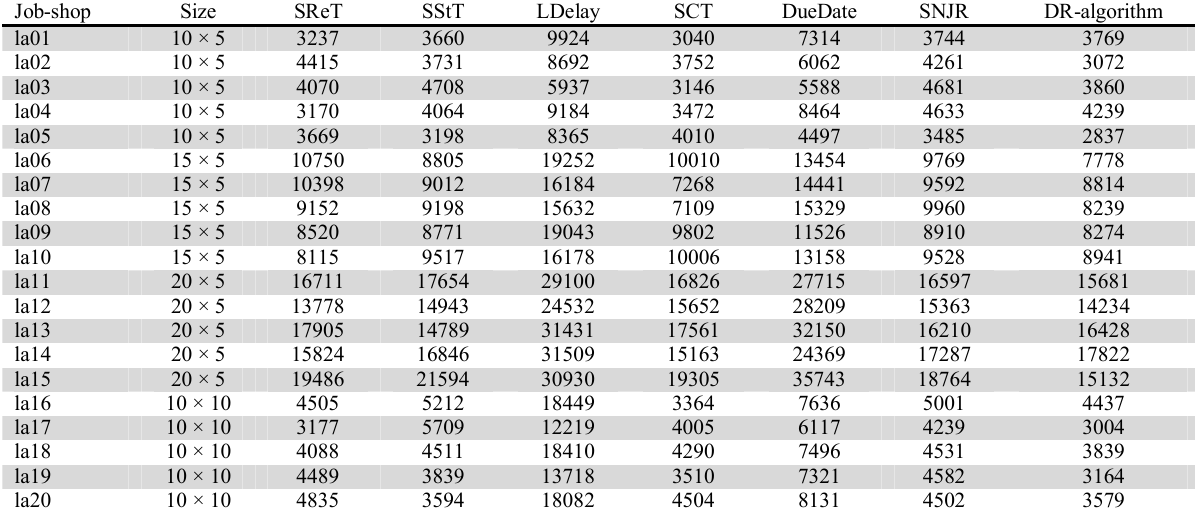
A comparison of DR-algorithm with six heuristic algorithms based on despatching rules for the